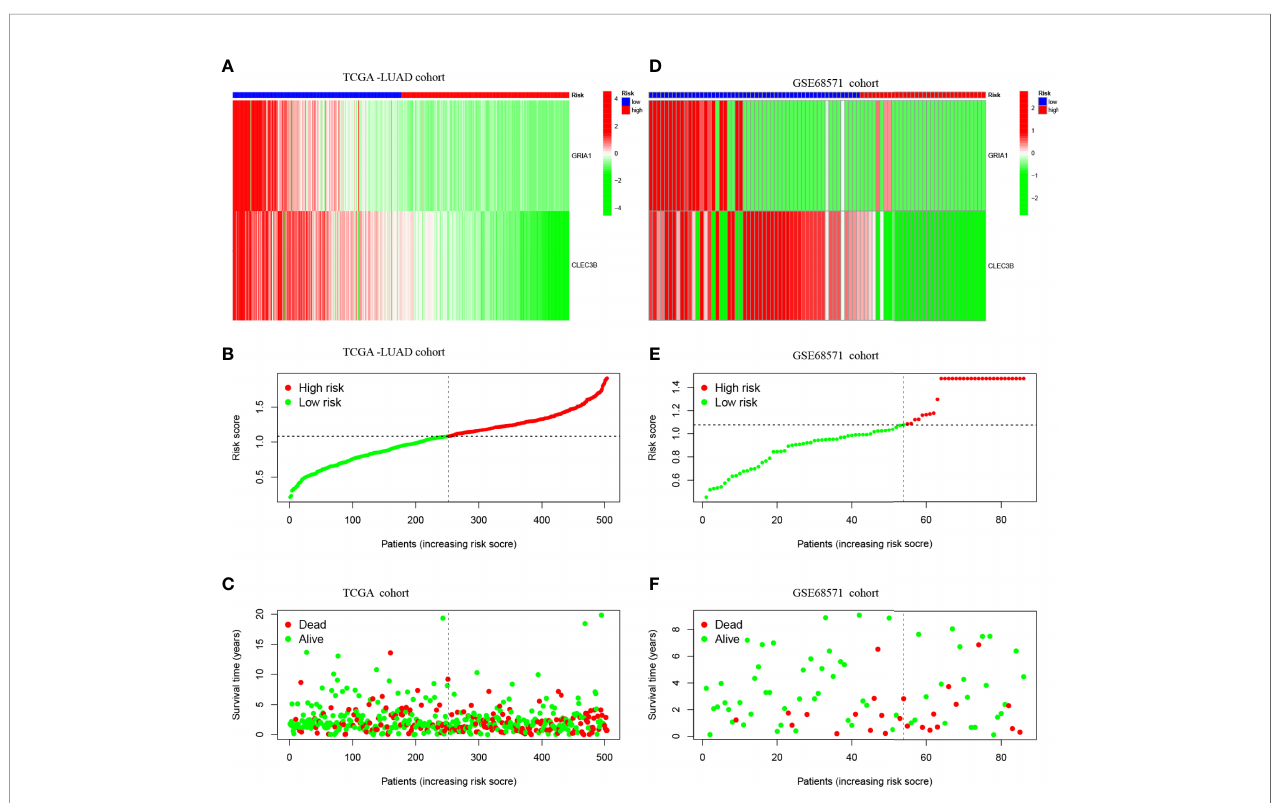
FIGURE 4 | (A) Con fi rmation of prognostic risk scores in the TCGA cohort. (B) Polygenic model risk score distribution in TCGA cohort. (C) Survival status and duration of LUAD patients in TCGA cohort. (D) Con fi rmation of prognostic risk scores in the GSE68571 cohort. (E) Polygenic model risk score distribution in the GSE68571 cohort. (F) Survival status and duration of LUAD patients in the GSE68571